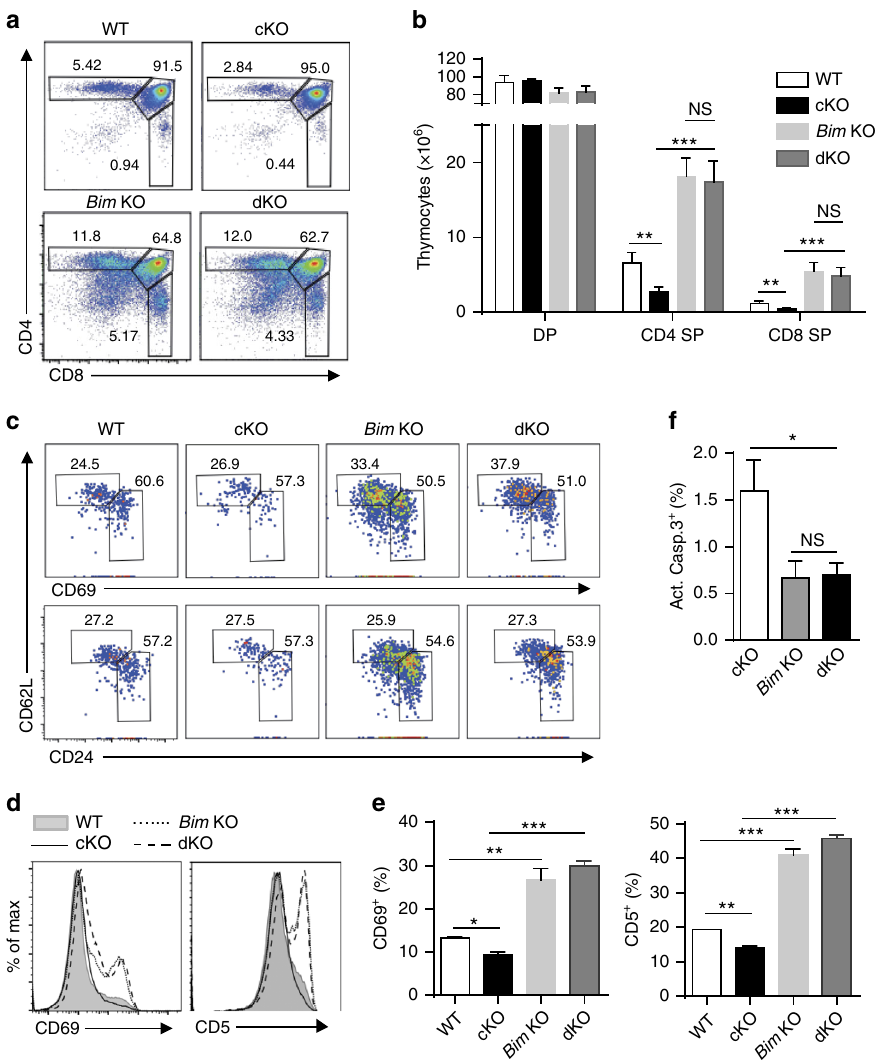
Fig. 6 Bim expression is responsible for the defective thymocyte development in NCoR1-de fi cient mice. a Flow cytometry analysis of CD4 and CD8 expression on thymocytes from wild-type (WT), NCoR1-de fi cient (cKO), Bim KO, Ncor1 and Bim double-knockout (dKO) mice. b The number of cells in each subpopulation gated in ( a ). c Expression of CD62L vs. CD69 or CD24 on CD4 + single-positive (SP) thymocytes from WT, cKO, Bim KO, and dKO mice. d The percentages of CD69- and CD5-positive subpopulations in ( c ). e Flow cytometry analysis of CD69 and CD5 expression on total thymocytes from WT, cKO, Bim KO, and dKO mice. f Intracellular levels of the active caspase-3 (Act.Casp.3) in thymocytes activated in vitro for 1 h. The data are representative of two independent experiments ( n = 2 or 3). Statistical signi fi cance was analyzed using the two-tailed Student ’ s t test (* P < 0.05; ** P < 0.01; *** P < 0.001; NS, not signi fi